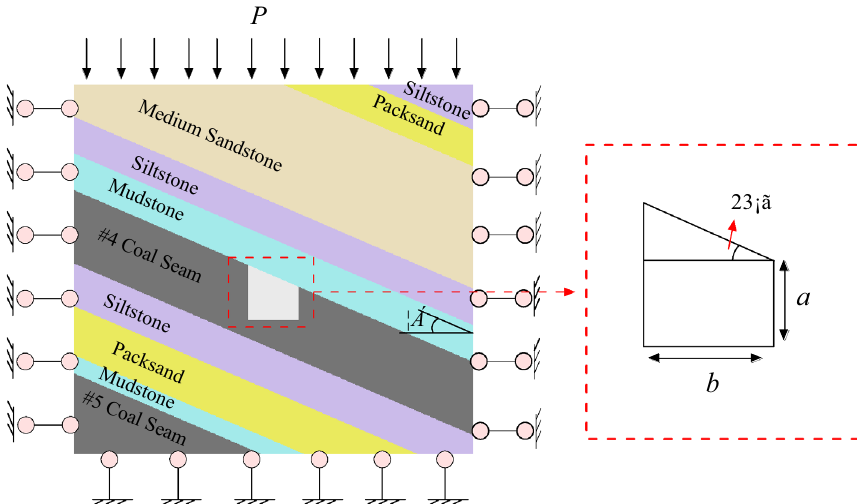
Figure 3. Structure diagram of inclined coal seam